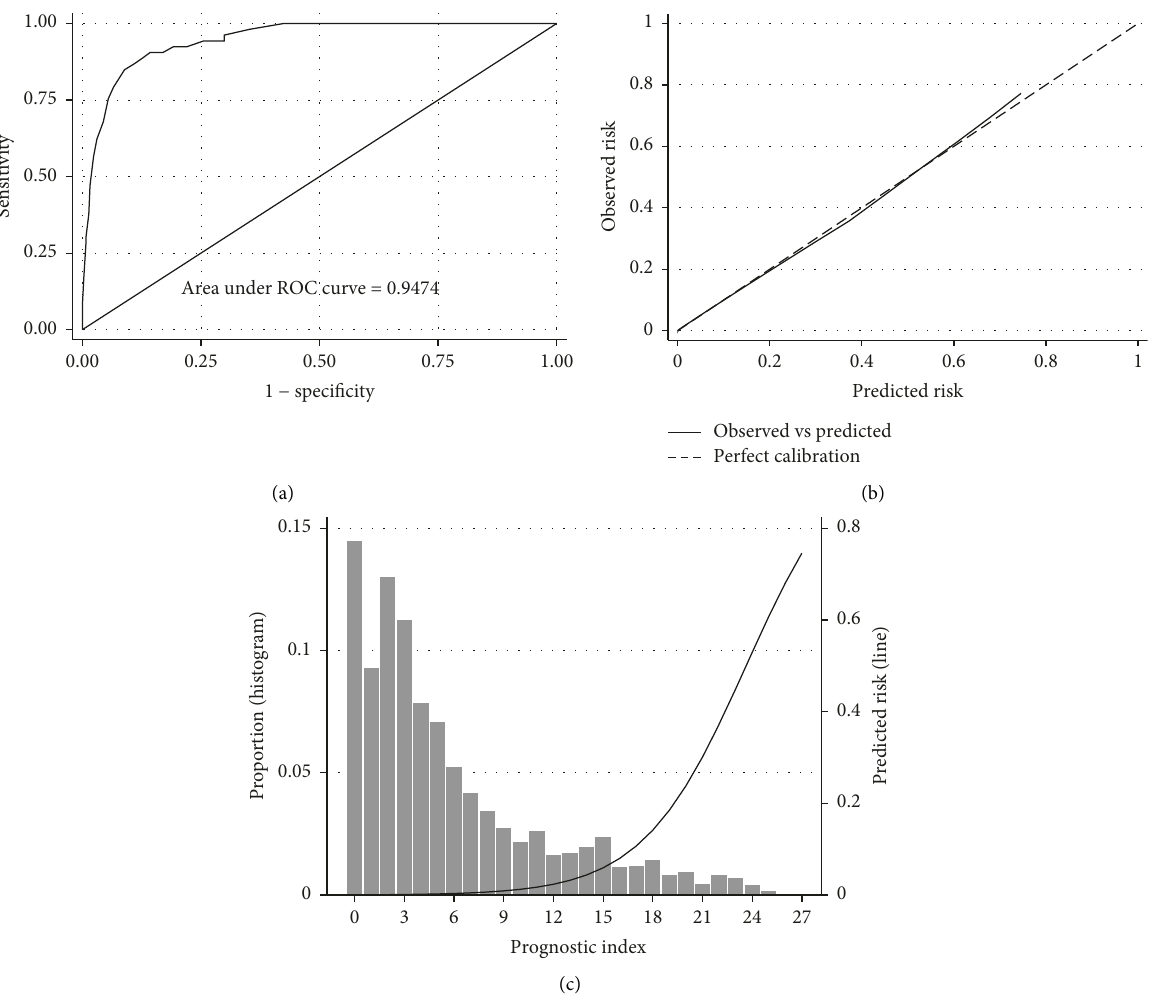
Figure 5: Discrimination (a), calibration (b), distribution of cases (c), and predicted probability (lower panel line) of the model to predict mortality in the validation